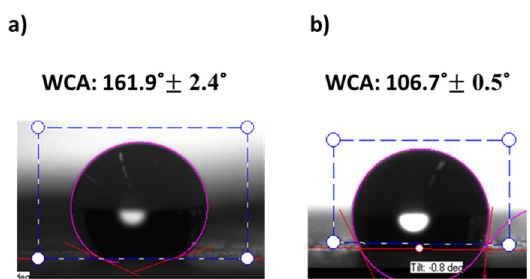
Figure 19. Static water contact angles (WCA) of samples S3G ( a ) and S3G-SLIPS ( b ). The sample S3G ( a ) exhibits a superhydrophobic behavior (WCA < 150°) and samples S3G-SLIPS ( b ) a hydrophobic behavior (90° < WCA < 150°).